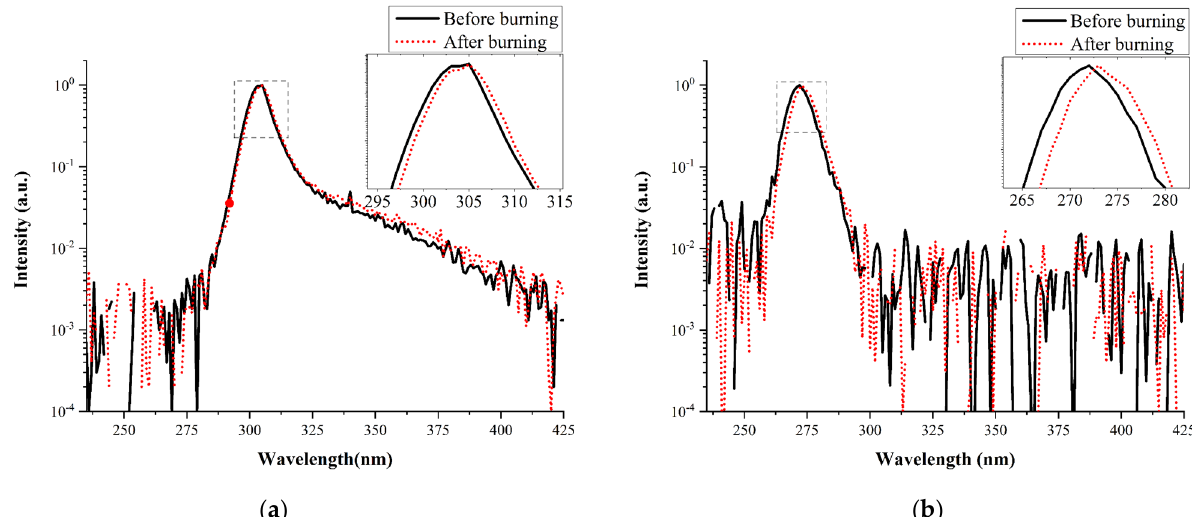
Figure 2. EL band peak positions measured at room temperature before and after the burning tests of ( a ) sample A ( V f = 5.246 V @40 mA) and ( b ) sample B ( V f = 5.530 V @40 mA). The inset is the enlargement of the peak portion.